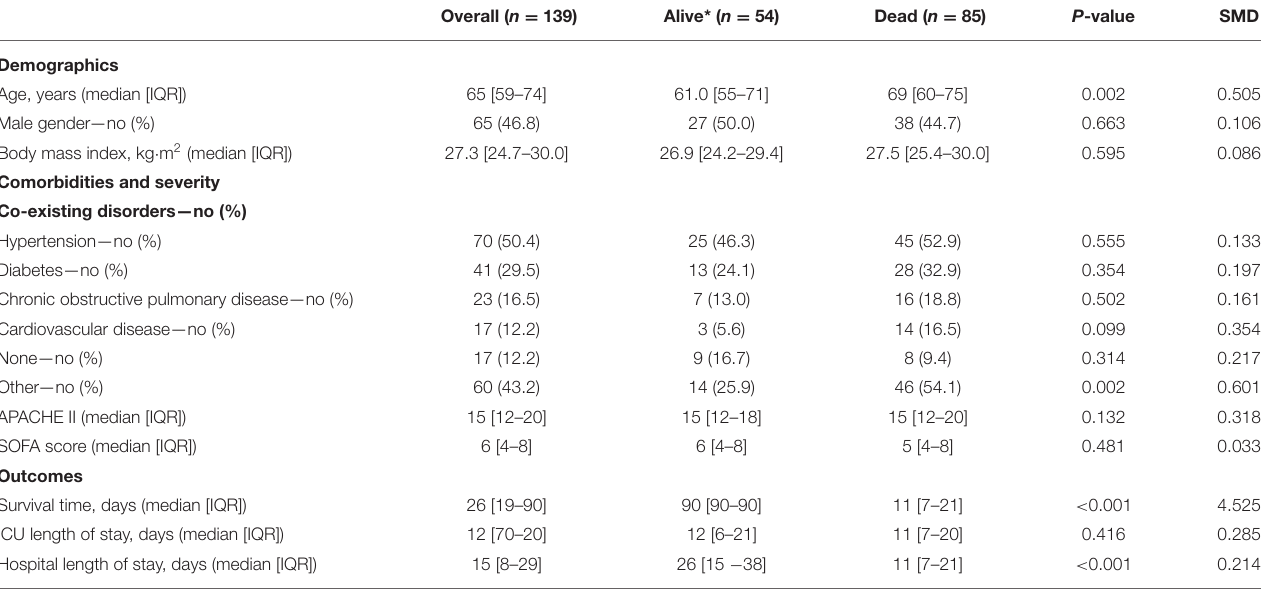
TABLE 1 | Baseline characteristics of the patients.